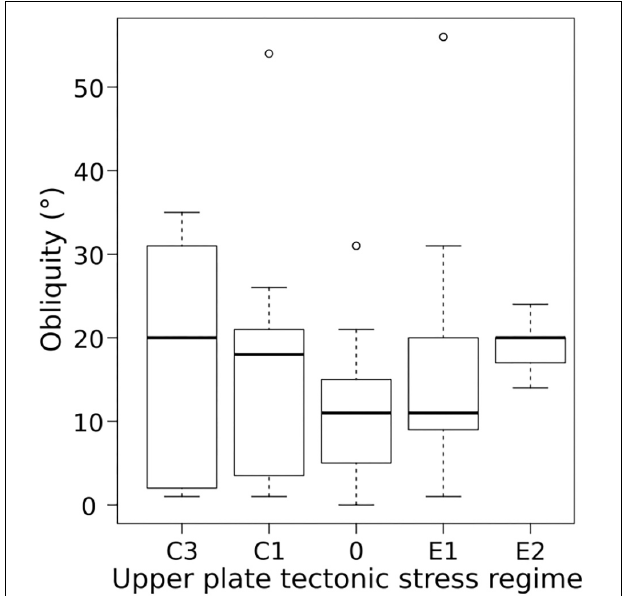
FIGURE 10 | A box and whisker plot for the five types of upper crustal tectonic stress regime for the 162 volcanoes analyzed, according to the classifications of Lallemand et al. (2005). E3 to E1 represent decreasing rates of extension, 0 represents an upper crust in neither extension nor compression, and C1 to C3 represent increasing rates of compression. No volcanoes in this study are found in regions of compression with class C2 or extension with class E3. Low convergence obliquity is most likely to be recorded in compressive volcanic arcs (C3,